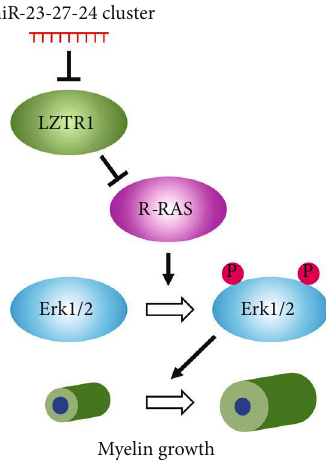
Figure 12: Role of miR-23-27-24 clusters in myelin formation. The miR-23-27-24 cluster enhances myelin growth in adults by negatively regulating LZTR1, promoting R-RAS expression, and activating the Mek/Erk1/2-MAPK